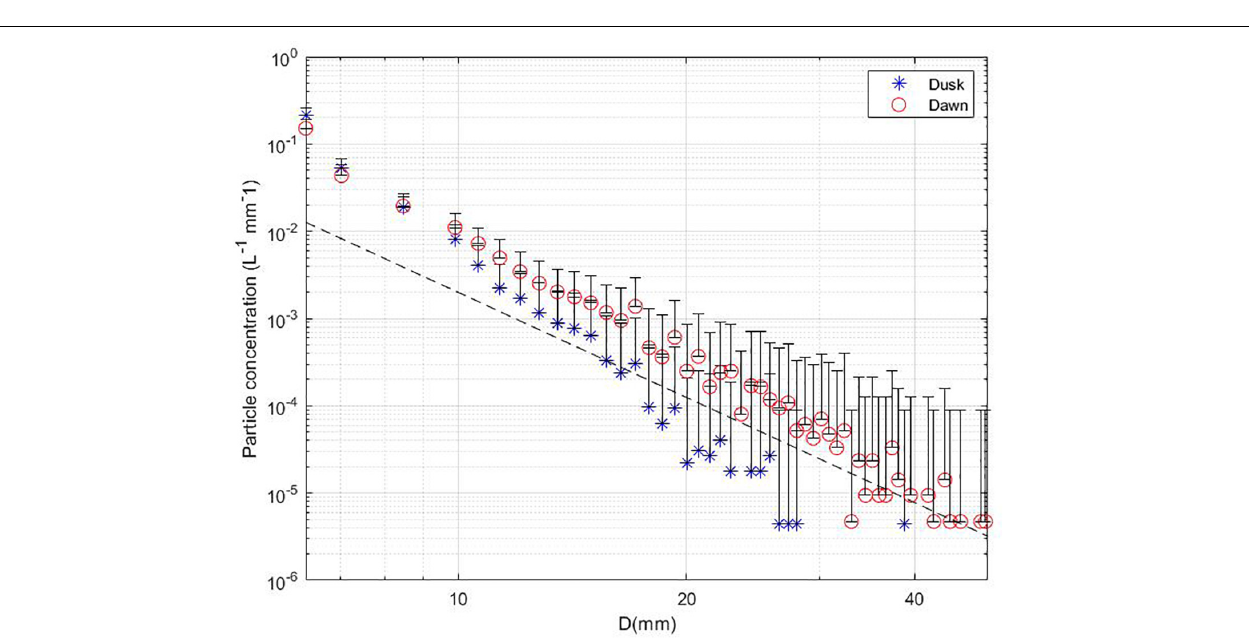
FIGURE 5 | Average particle concentrations for dense scan mode at dusk (blue stars) and dawn (red circles); error bars represent one positive standard deviation. Large particles ( > 50 mm) are not shown due to insufficient numbers sampled. Dotted line represents the steady state slope of − 4.